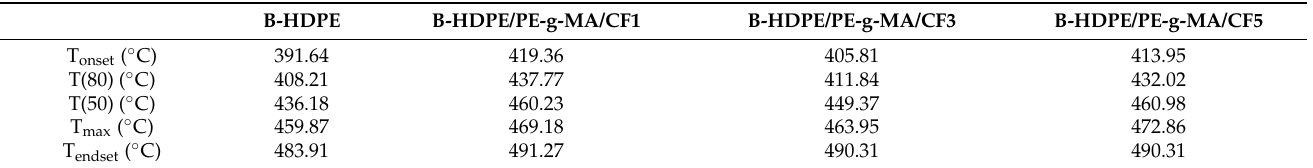
Figure 5. ( a ) TGA and ( b ) DTG curves of B-HDPE and biocomposites. Table 3. T onset , temperatures at 80% and 50% mass loss, T max and T endset , of TG and DTG of B-HDPE and its